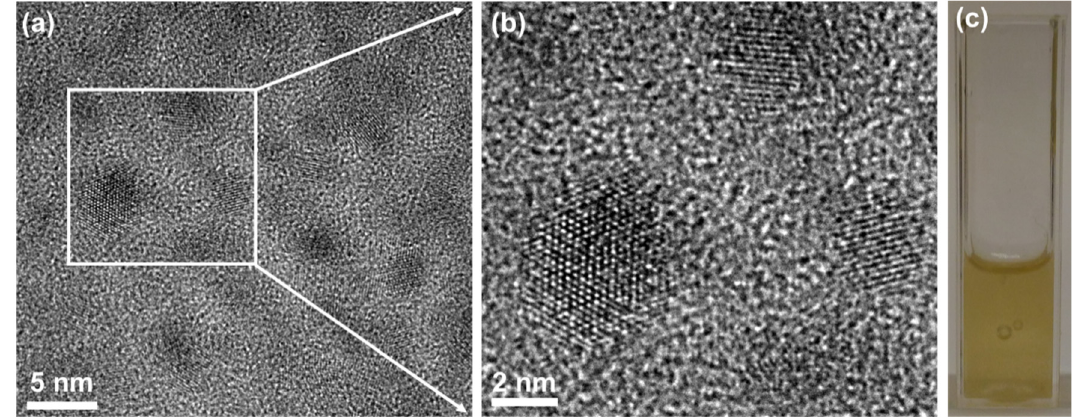
Figure 2. ( a , b ) HRTEM images of AgNCs-PMAA; ( c ) photograph of the AgNCs embedded in the PEGDA matrix inside the plastic cuvette.